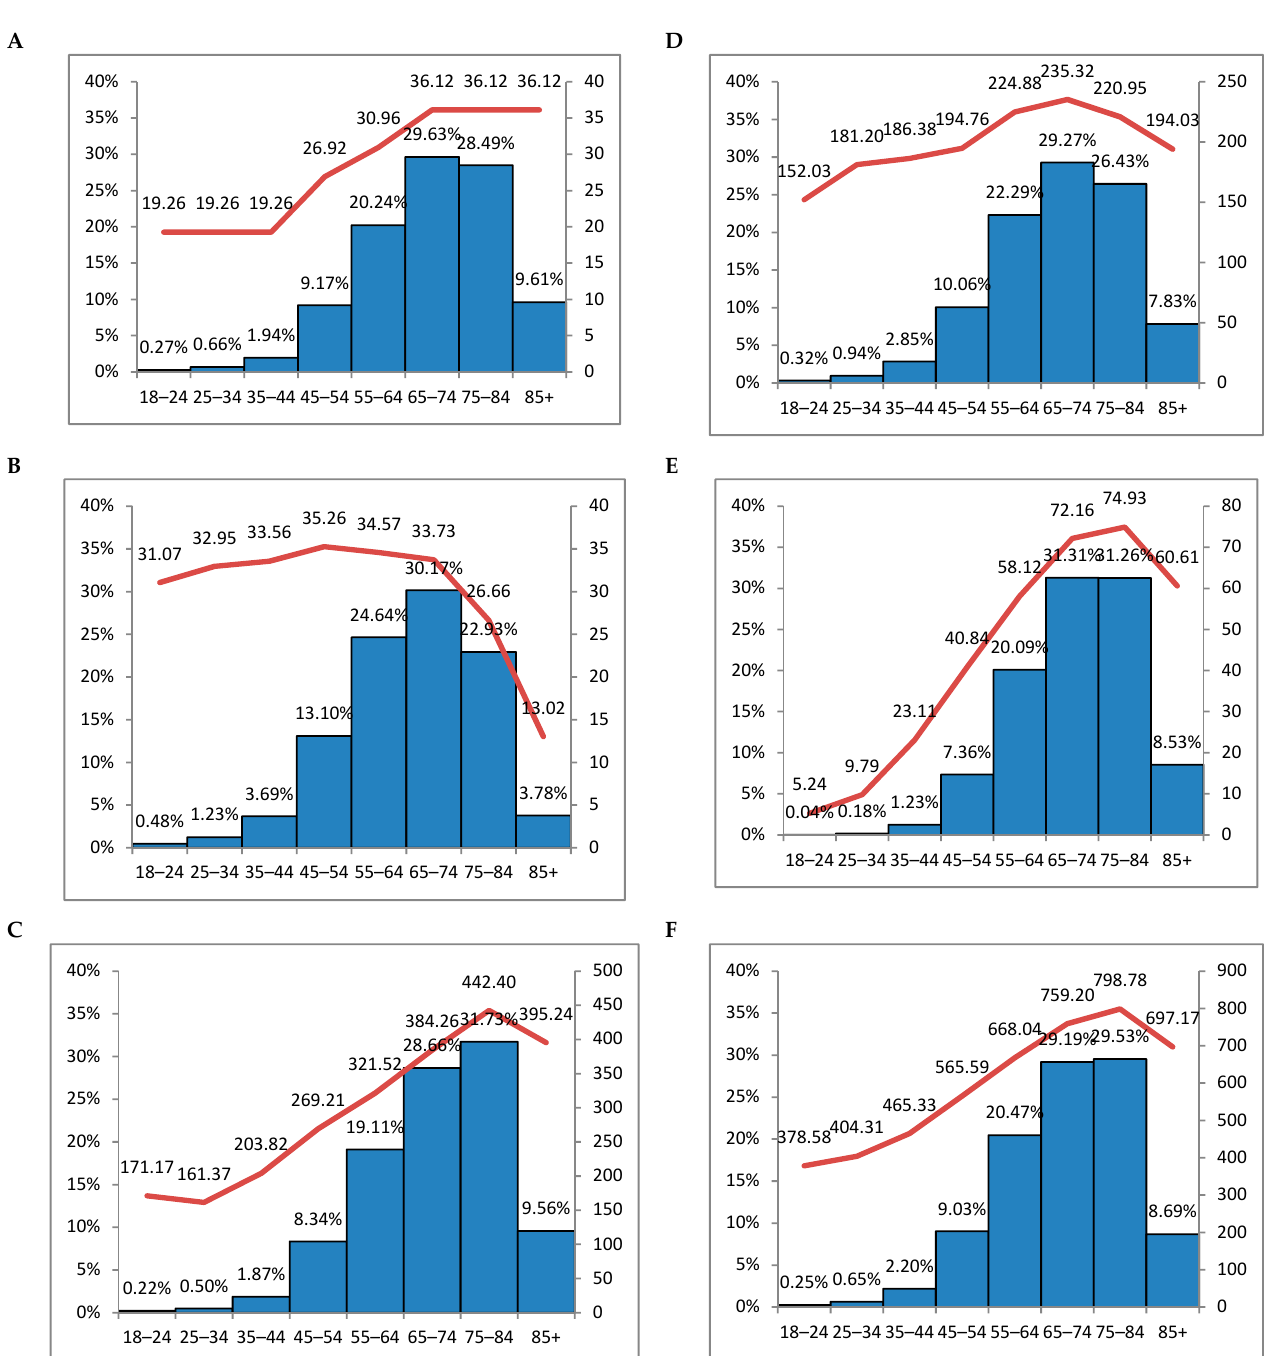
Figure 3. The average amount spent in EUR per person for one year plotted against the proportion of expenses in age groups: ( A )—primary care cost; ( B )—outpatient cost; ( C )—hospitalization cost; ( D )—the cost of reimbursed medications; ( E )—the cost of medications paid out of pocket; ( F )—total cost ( A + B + C + D + E ). Bars—proportions of expenses in age groups; line—the average amount in EUR per person per year.